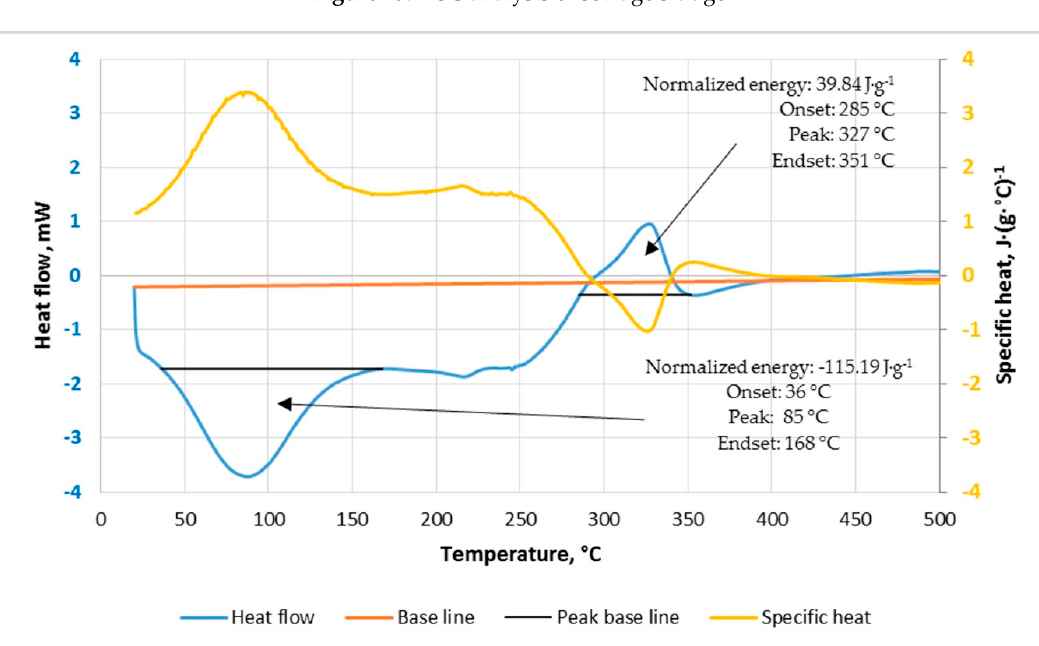
Figure 15. DSC analysis of sewage sludge. Energies 2020 , 13 , x FOR PEER REVIEW